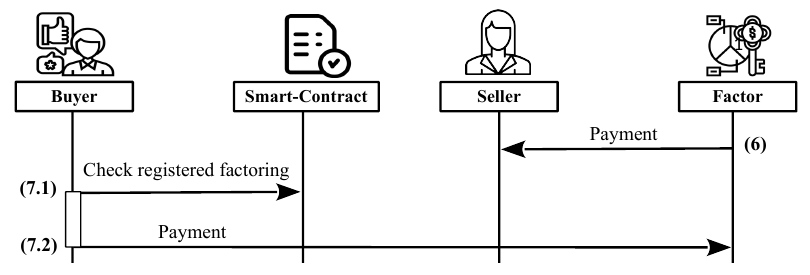
Figure 5. Payment